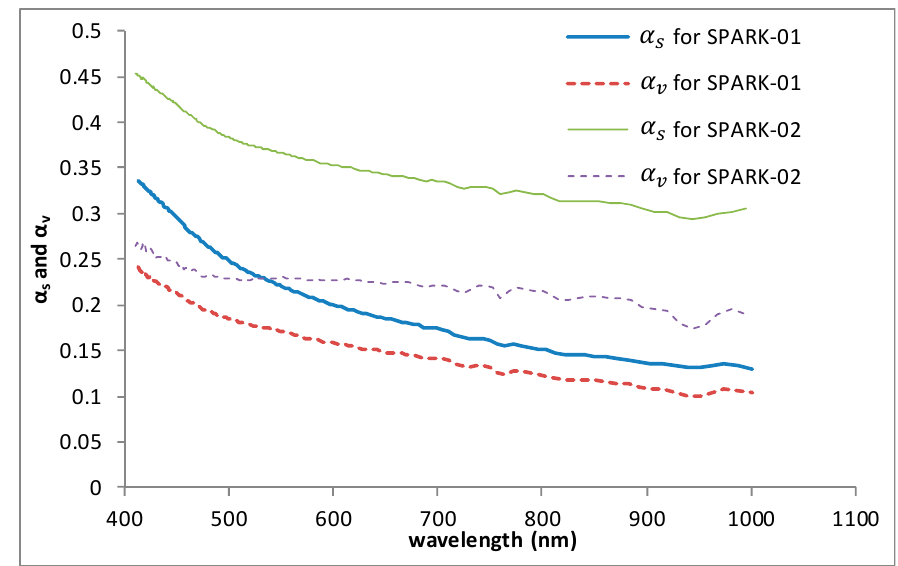
Figure 17. Diffuse-to-global irradiance ratio extrapolated and interpolated to the solar direction ( α s ) and viewing direction ( α v ) during the satellite overpasses.